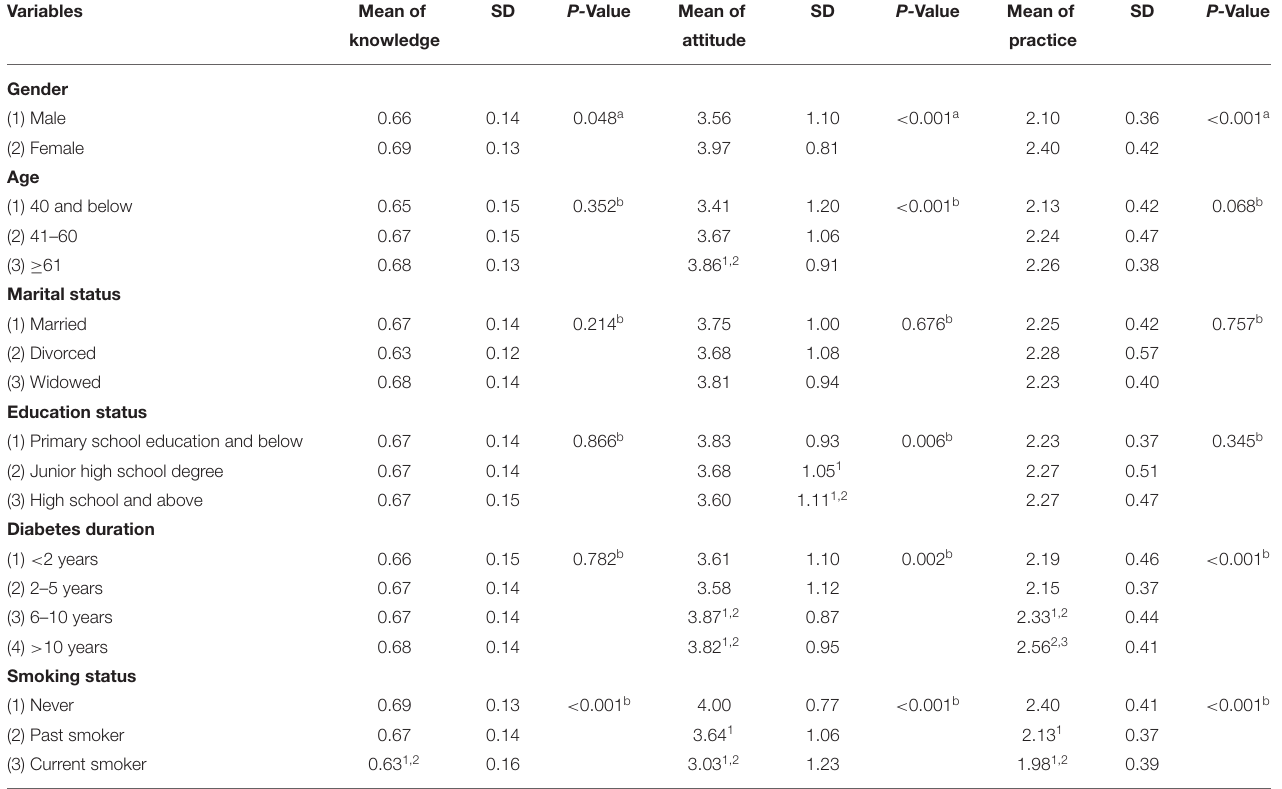
TABLE 5 | Univariate analysis of diabetic foot prevention knowledge, attitudes, and foot self-care practices. Variables Mean of SD P- Value Mean of SD P- Value Mean of SD P- Value knowledge attitude practice